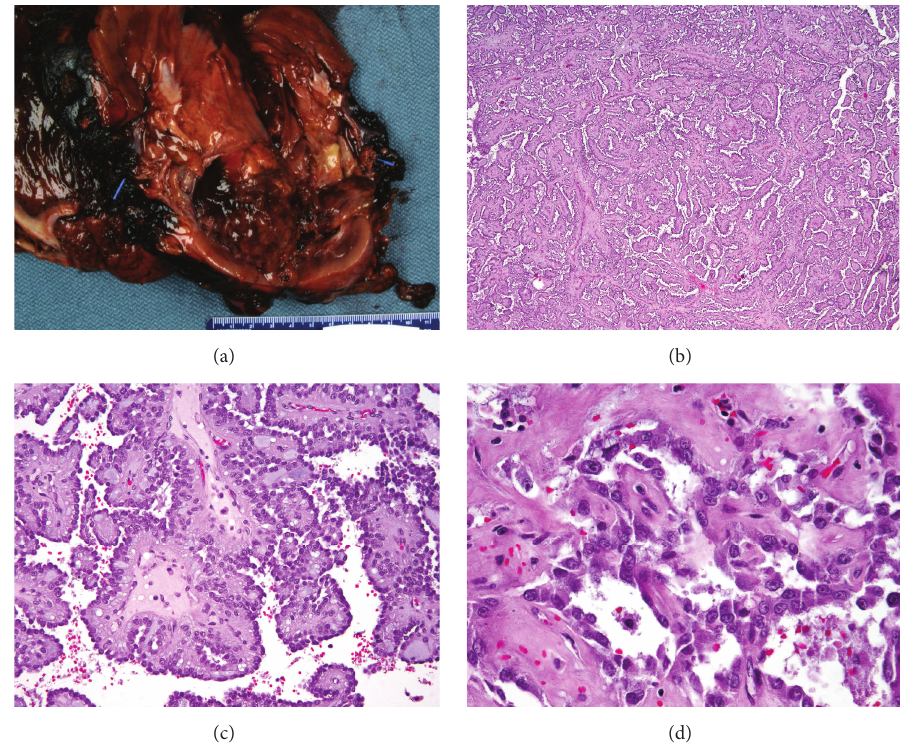
Figure 2: (a) Gross specimen of right radical nephrectomy demonstrating papillary renal cell carcinoma. (b) Low power H&E stained representation of papillary type 2 renal cell carcinoma. (c) H&E stained slide demonstrating papillary architecture. (d) H&E stained representtion of cytologic and nuclear